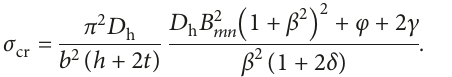
1) along the x (cid:31)